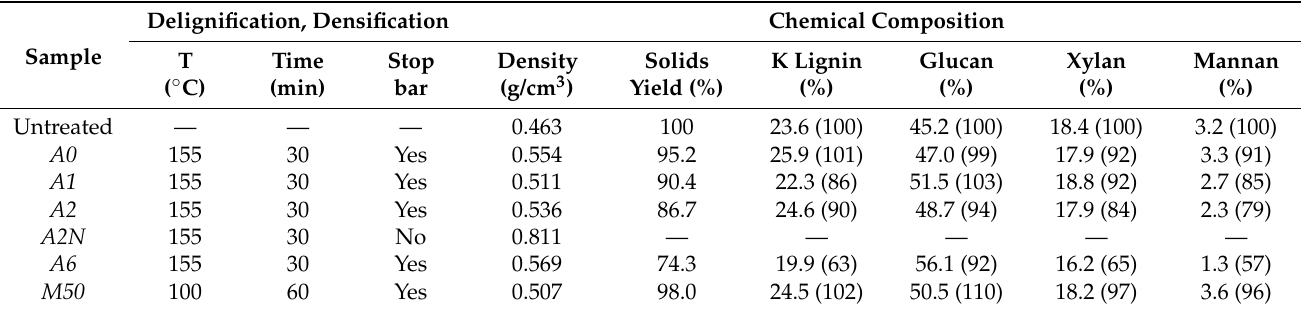
Table 1. List of wood delignification and densification conditions, and chemical composition